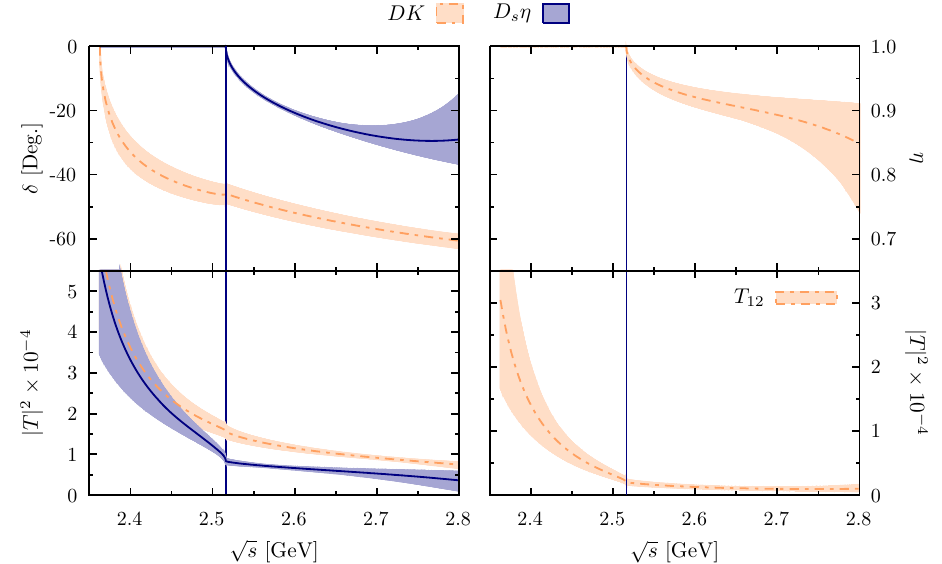
. The vertical line indicates the D s η threshold. Error bands have U